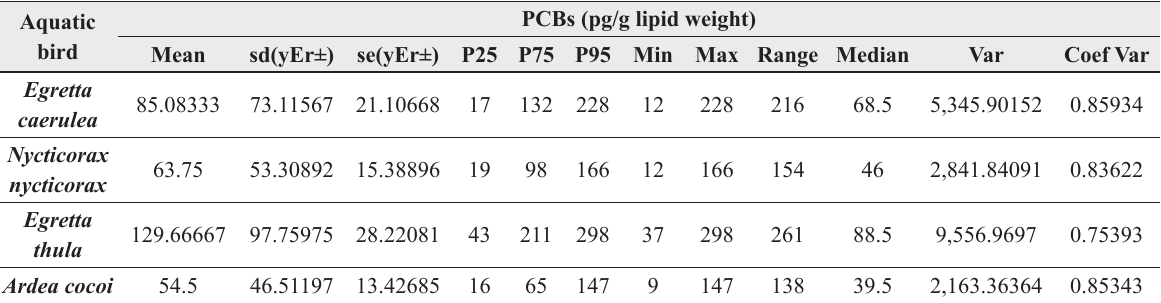
Descriptive statistics of PCBs concentrations (pg/g lipid weight) in aquatic